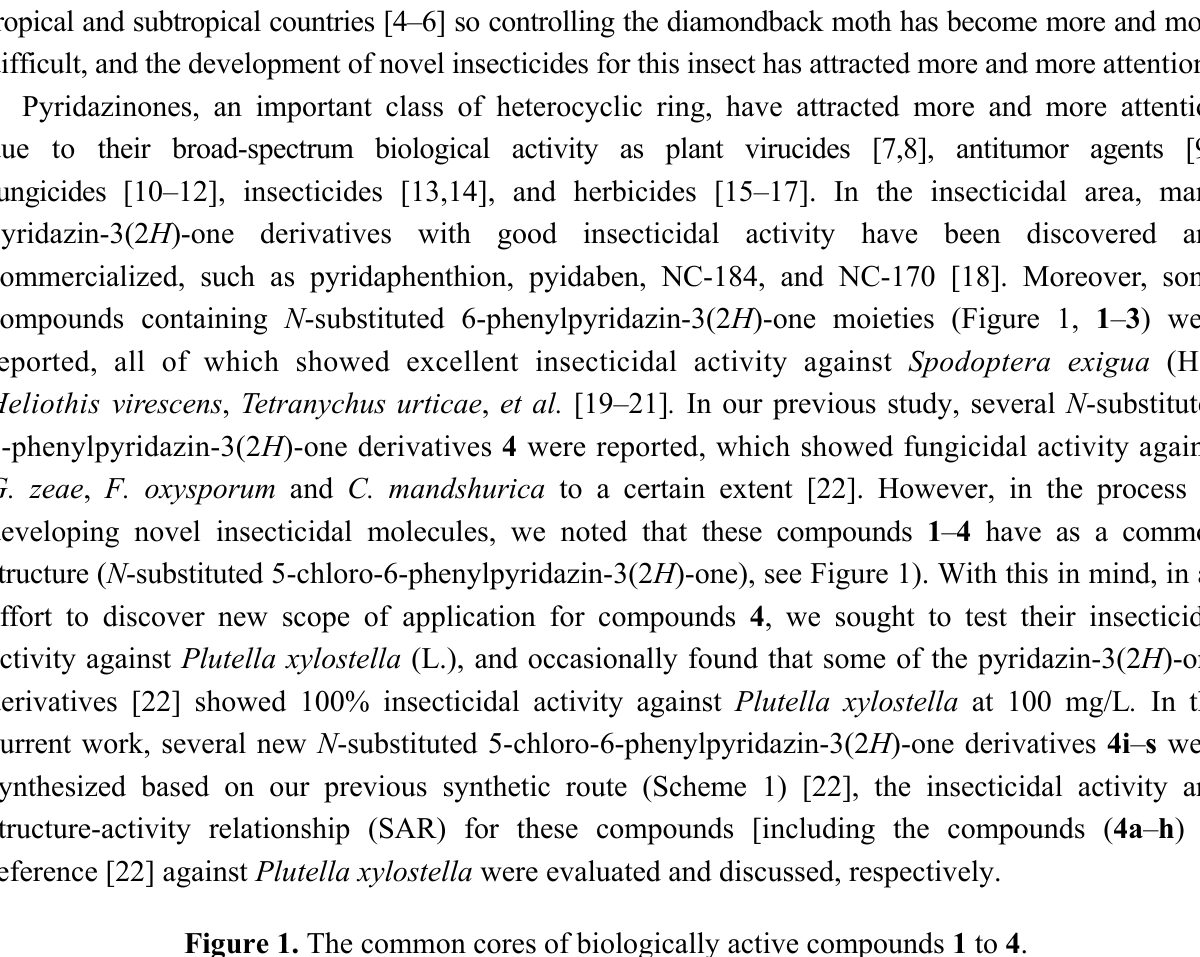
Figure 1. The common cores of biologically active compounds 1 to 4